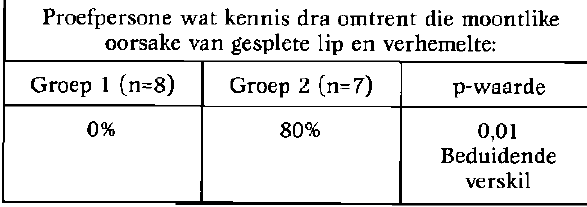
Tabel 2: Vergelyking van Groep 1 en Groep 2 se kennis oor moontlike oorsake van gespelete verhemelte.